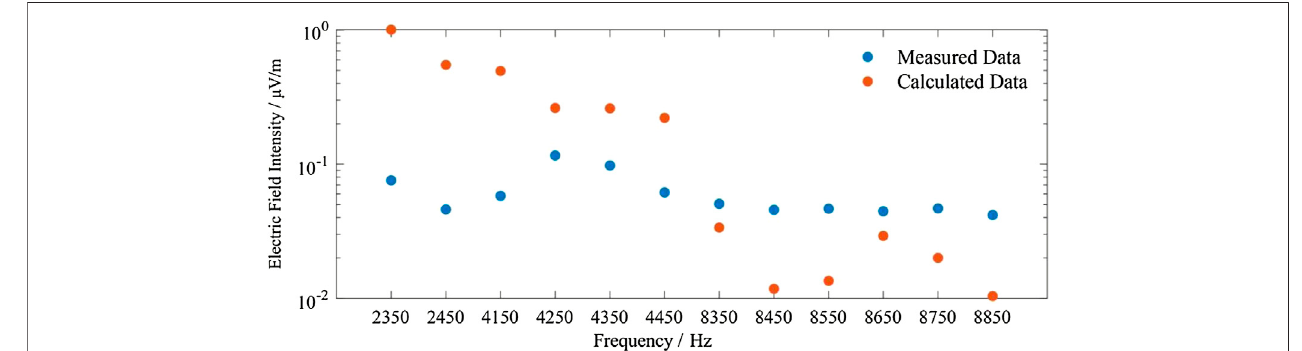
FIGURE 8 | Comparison of the electric fi eld intensity observed by DEMETER and calculated by FWM.